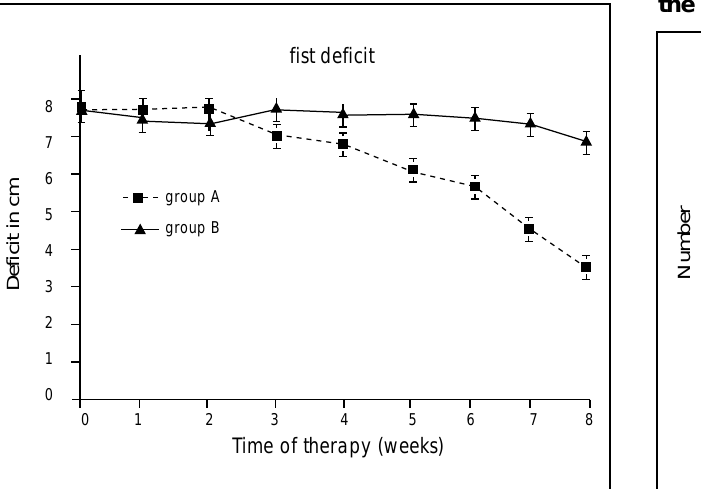
Figure 6: The development of the fist deficit, repre- senting the function of the long fingers.